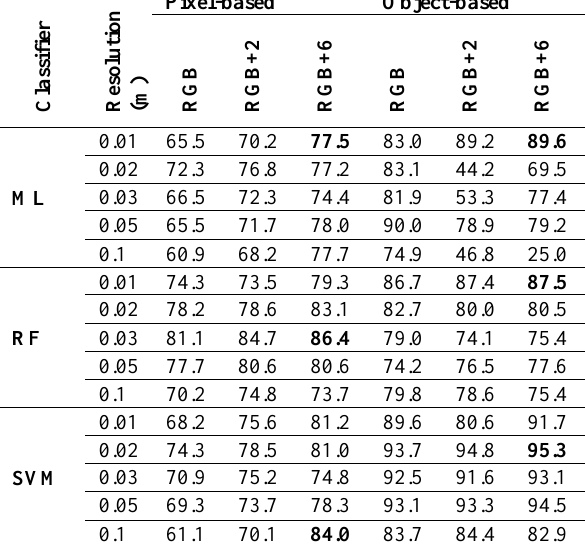
Table 1. Overall Accuracy (OA) between three classifiers under different image resolutions with different input variables